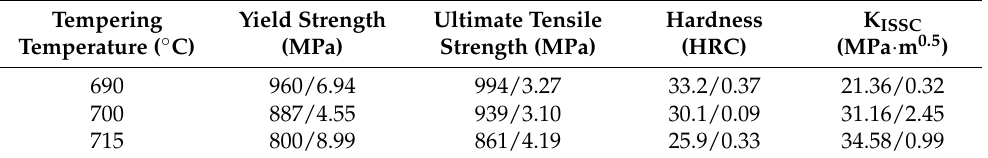
Table 2. The mechanical properties and K ISSC values with standard deviations of the 0.5Cr0.4W steels tempered at different temperatures.